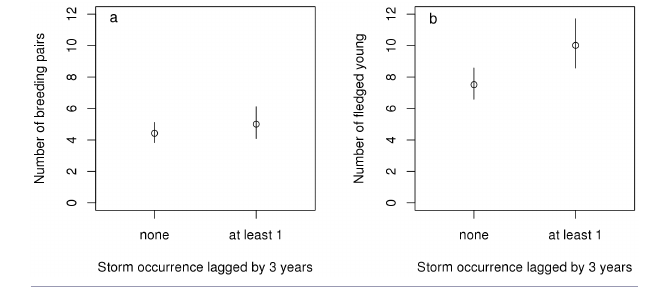
Fig. 5 . Total number of Piping Plover ( Charadrius melodus melodus ) nesting pairs and fledged young at the study sites, 1986-2012, in southeastern New Brunswick, Canada. Arrows indicate the occurrence of storms relative to the breeding season.